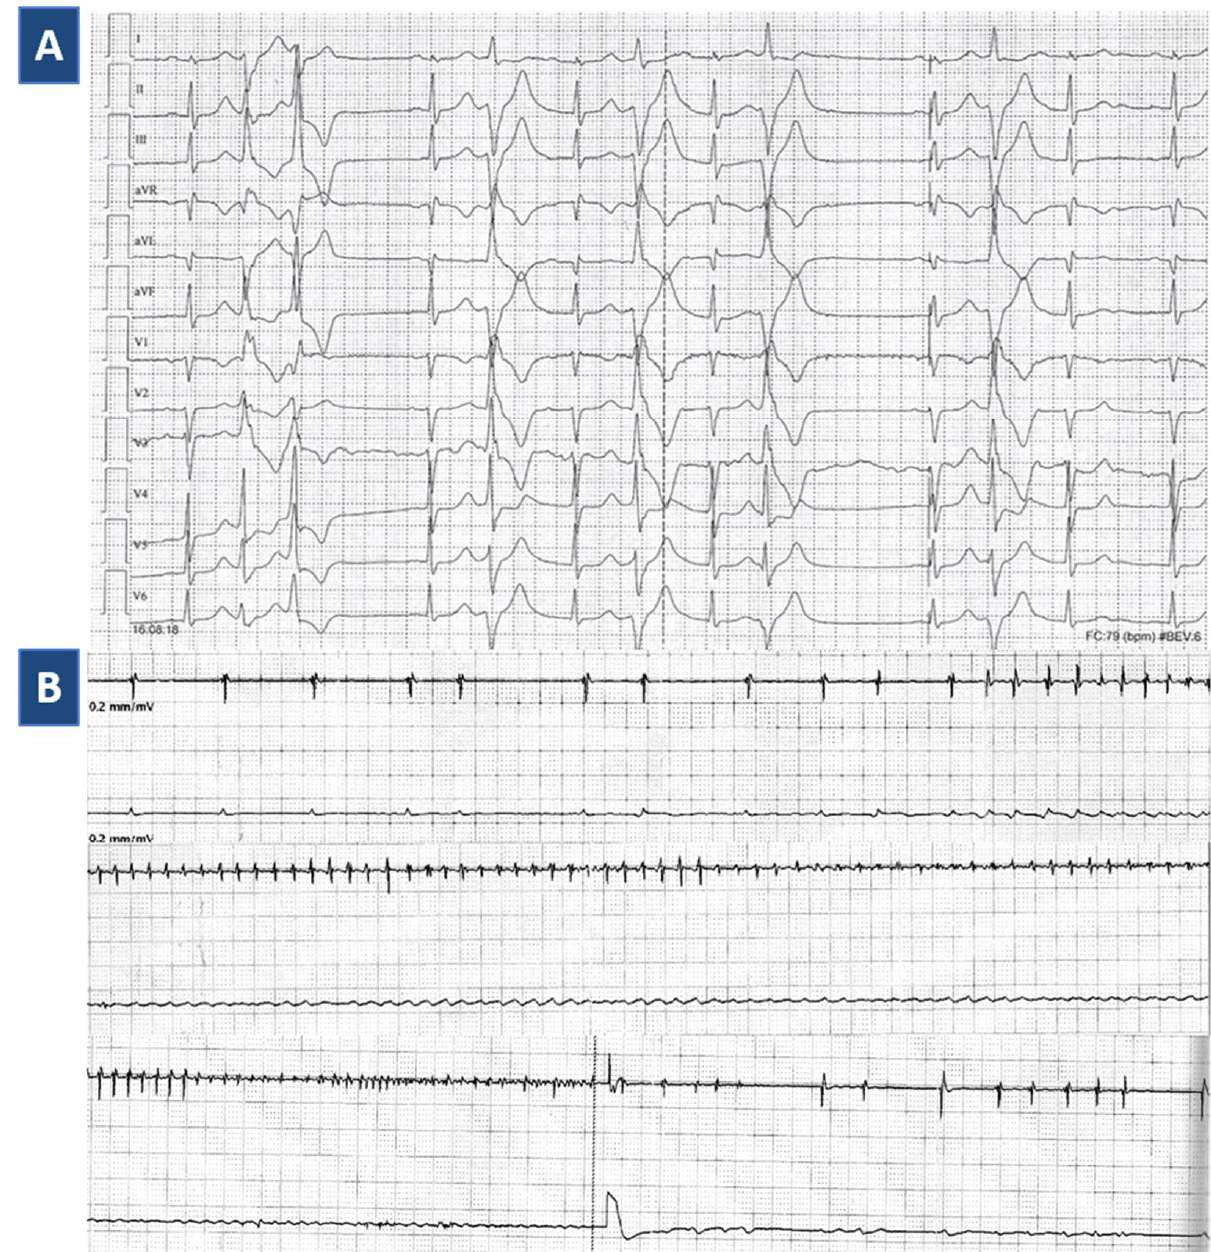
Figure 2. ECG: Ventricular arrhythmias. Legend. ( A ) ECG shows sinus rhythm, with frequent premature ventricular complexes of two morphologies, with bigeminal beats and a couple. The dominant clinical morphology is right-bundle branch block superior axis, suggesting an origin from the inferolateral wall of the left ventricle. ( B ) Ventricular fibrillation episode (49 s, 284 bpm) detected by implantable cardioverter defibrillator and terminated by appropriate shock, three years after immunosuppressive therapy termination.